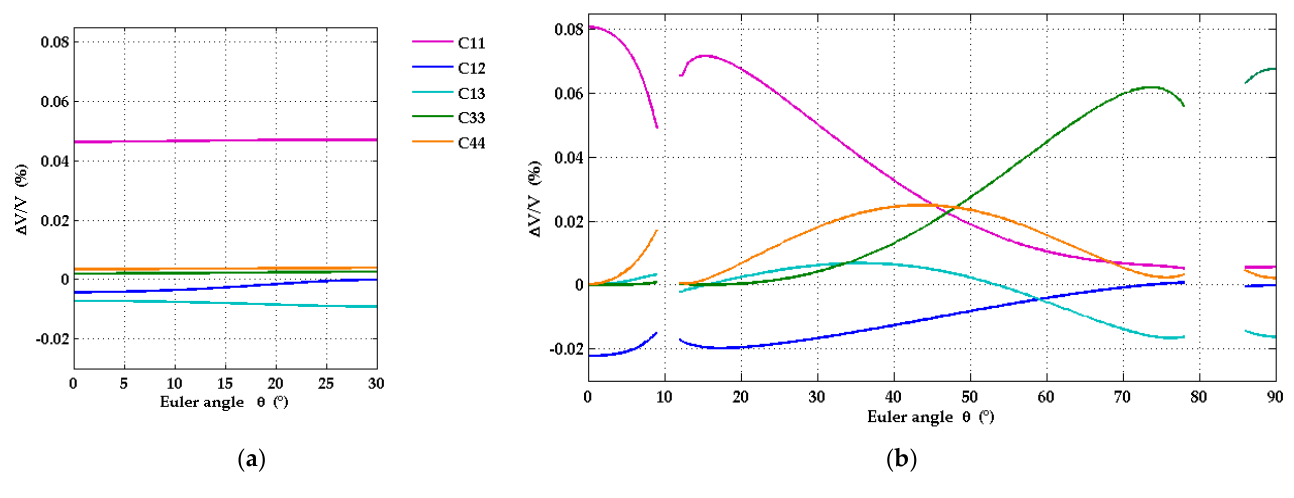
Figure 11. Calculated relative change of phase velocity with 1% increase of elastic constants for Mo/Al 0.77 Sc 0.23 /Al 2 O 3 structures with 1 µm thick Al 0.77 Sc 0.23 N film and additional Mo coating with 50 nm thickness, as a function of SAW propagation direction on the surface. (a) case of AlScN(0001)/Al 2 O 3 ( 0001) and (b) AlScN(11-20)/Al 2 O 3 (1-102).